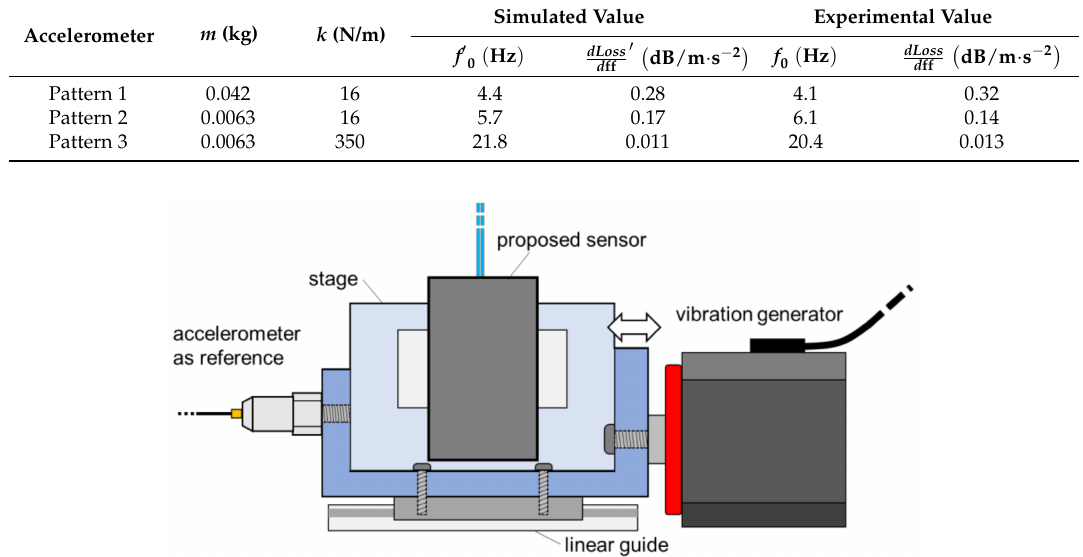
Table 1. The combinations of m and k of the proposed accelerometer, and simulated and experimental values of resonant frequency and sensitivity.